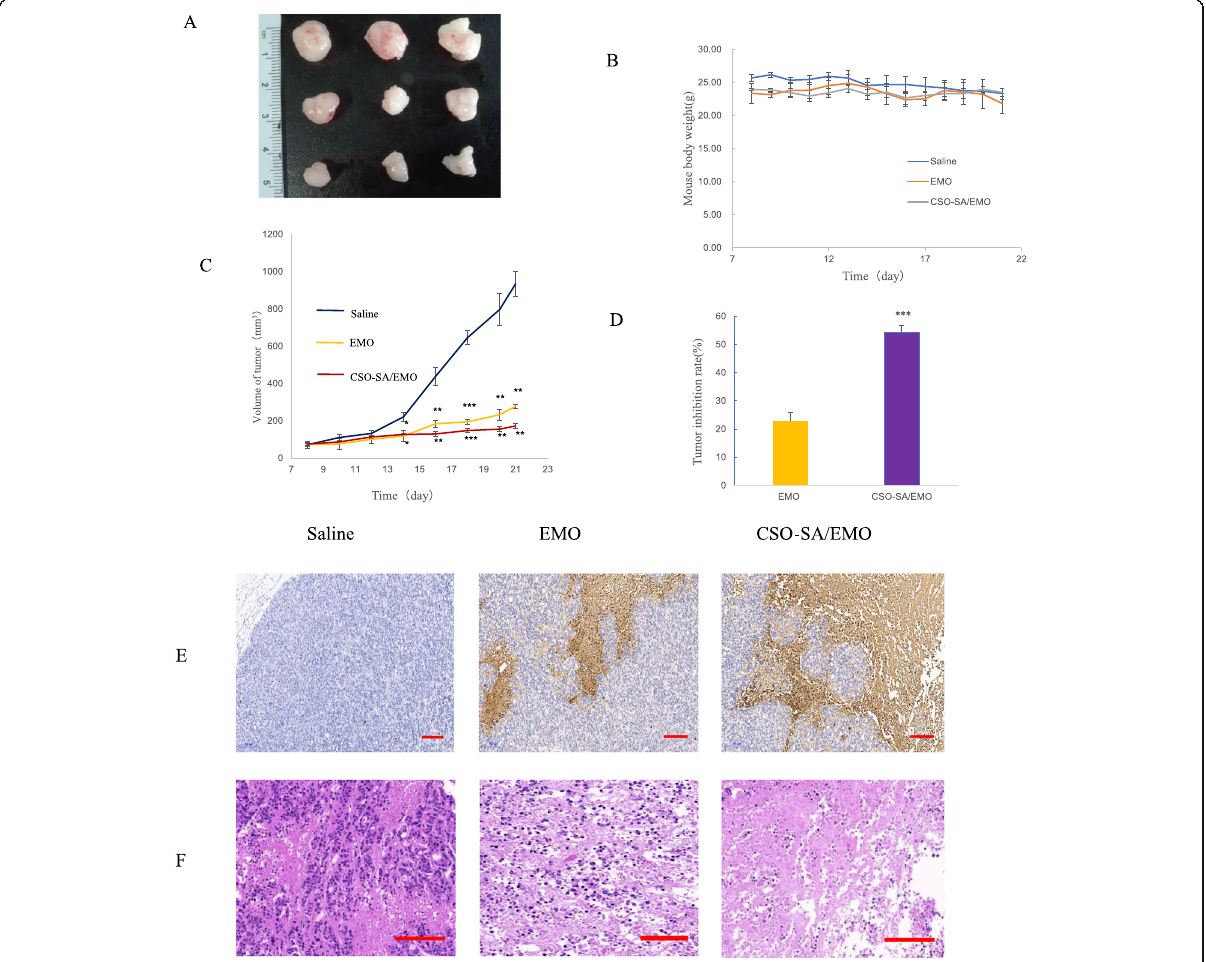
Fig. 9 Antitumor effect of CSO-SA/EMO in vivo. a Tumor shape in each group. b Mouse body weight in each group. c Tumor volume in each group. d Tumor inhibition rate. e Representative images of TUNEL-stained tumor tissue from each group (scale bar = 200 μ m). f Representative images of HE-stained tumor tissue from each group (scale bar = 200 μ